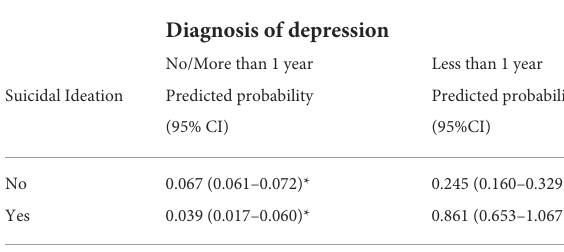
TABLE 2 The odds ratio (OR) and 95% confidence intervals (CI) of suicidal ideation according to sociodemographic and obstetric risk factors in the National Health Survey, Brazil 2019.